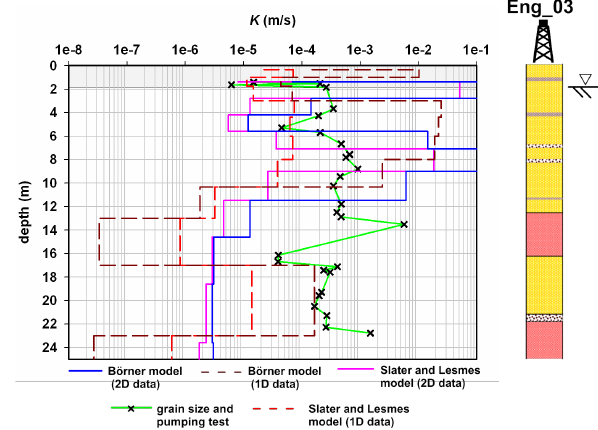
241 Fig. 11. Hydraulic conductivity at the location of borehole Eng_03. The green line: from coring 242 Fig. 11. Hydraulic conductivity at the location of borehole Eng_03. sleeves and grain size analysis using Kozeny equation. Red and pink lines: from Slater and 243 The green line: from coring sleeves and grain size analysis us- Lesmes (2002) model using sounding and profiling data, respectively. Brown and blue lines: 244 from Börner et al. (1996) model using 1D and 2D data, respectively. 245 ing Kozeny equation. Red and pink lines: from the Slater and Lesmes (2002) model using sounding and profiling data, respec- tively. Brown and blue lines: from the Börner et al. (1996) model using 1-D and 2-D data,